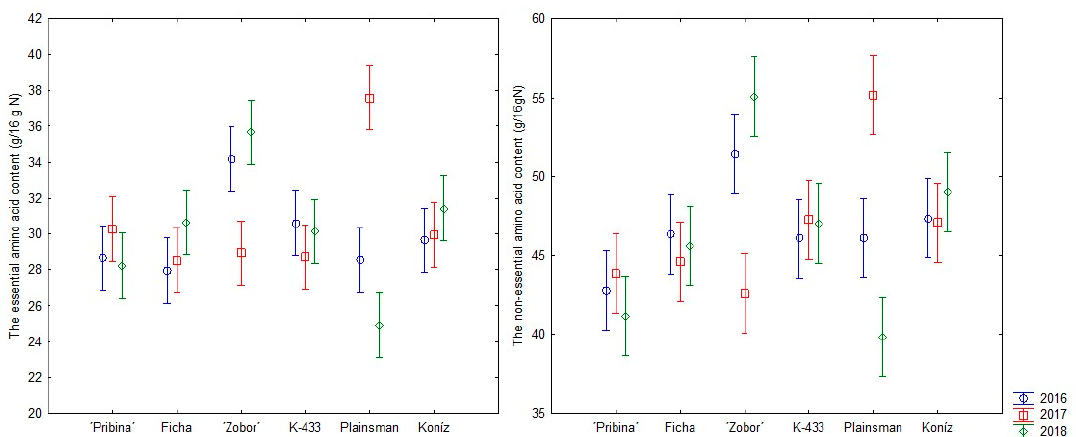
Figure 4. Comparison of consistency in content of essential and and nonessential amino acids over three growing seasons in amaranth samples. Individual columns represent 95% confidence intervals.